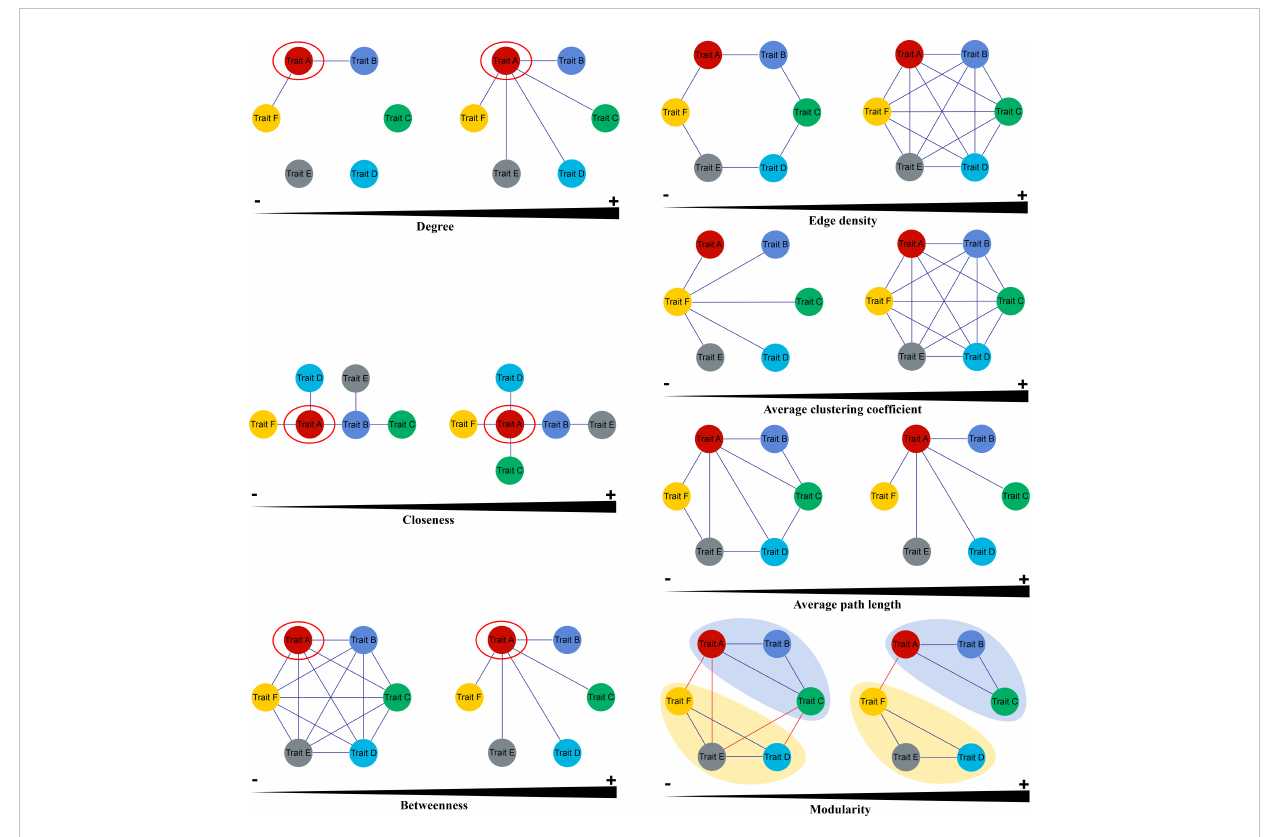
FIGURE 2 Key parameters of Plant Trait Network (Cited from He et al.,